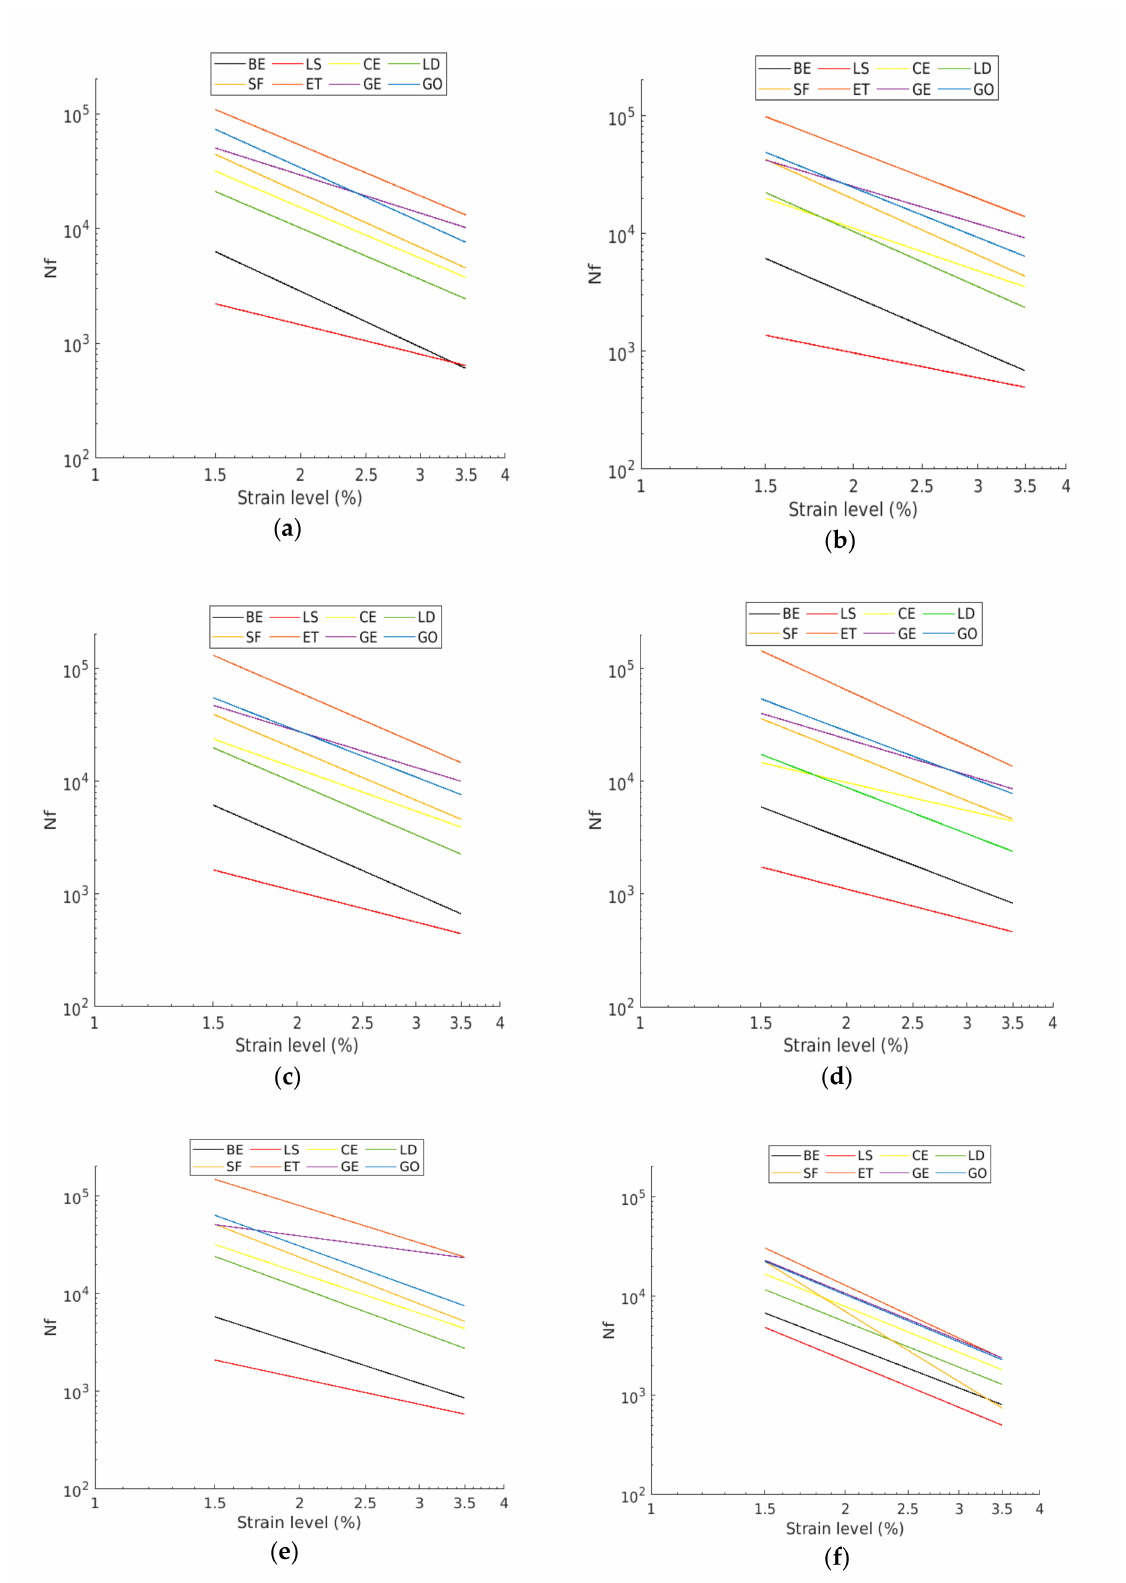
Figure 9. Fatigue laws derived from di ff erent failure approach: ( a ) G 50% ; ( b ) DPA; ( c ) DER; ( d ) RDEC; ( e ) ESR; ( f )